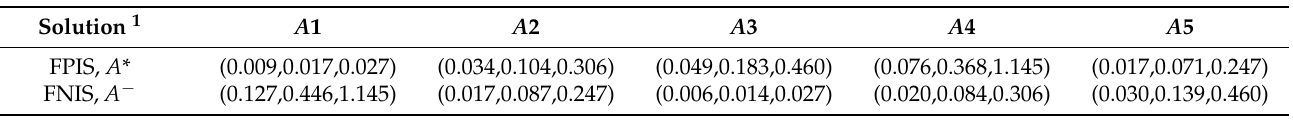
Table 10. Fuzzy Positive Ideal Solution (FPIS) and Fuzzy Negative Ideal Solution (FNIS) for the distance learning course structure.